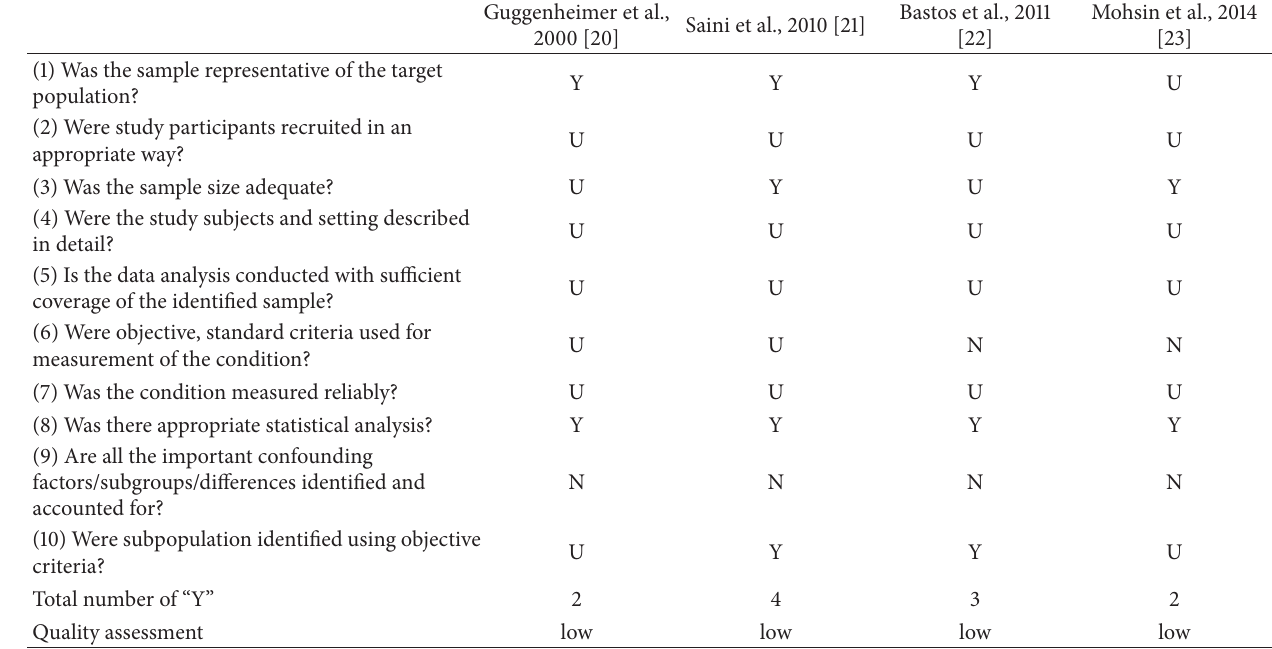
Table 3: JBI Critical Appraisal Checklist for studies reporting prevalence